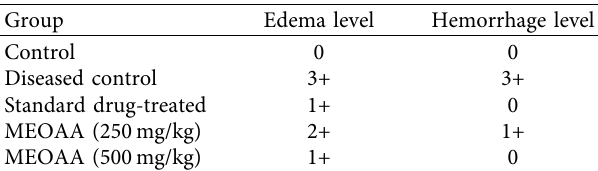
Table 1: Effect of Anagallis arvensis edema and hemorrhage of the urinary bladder.